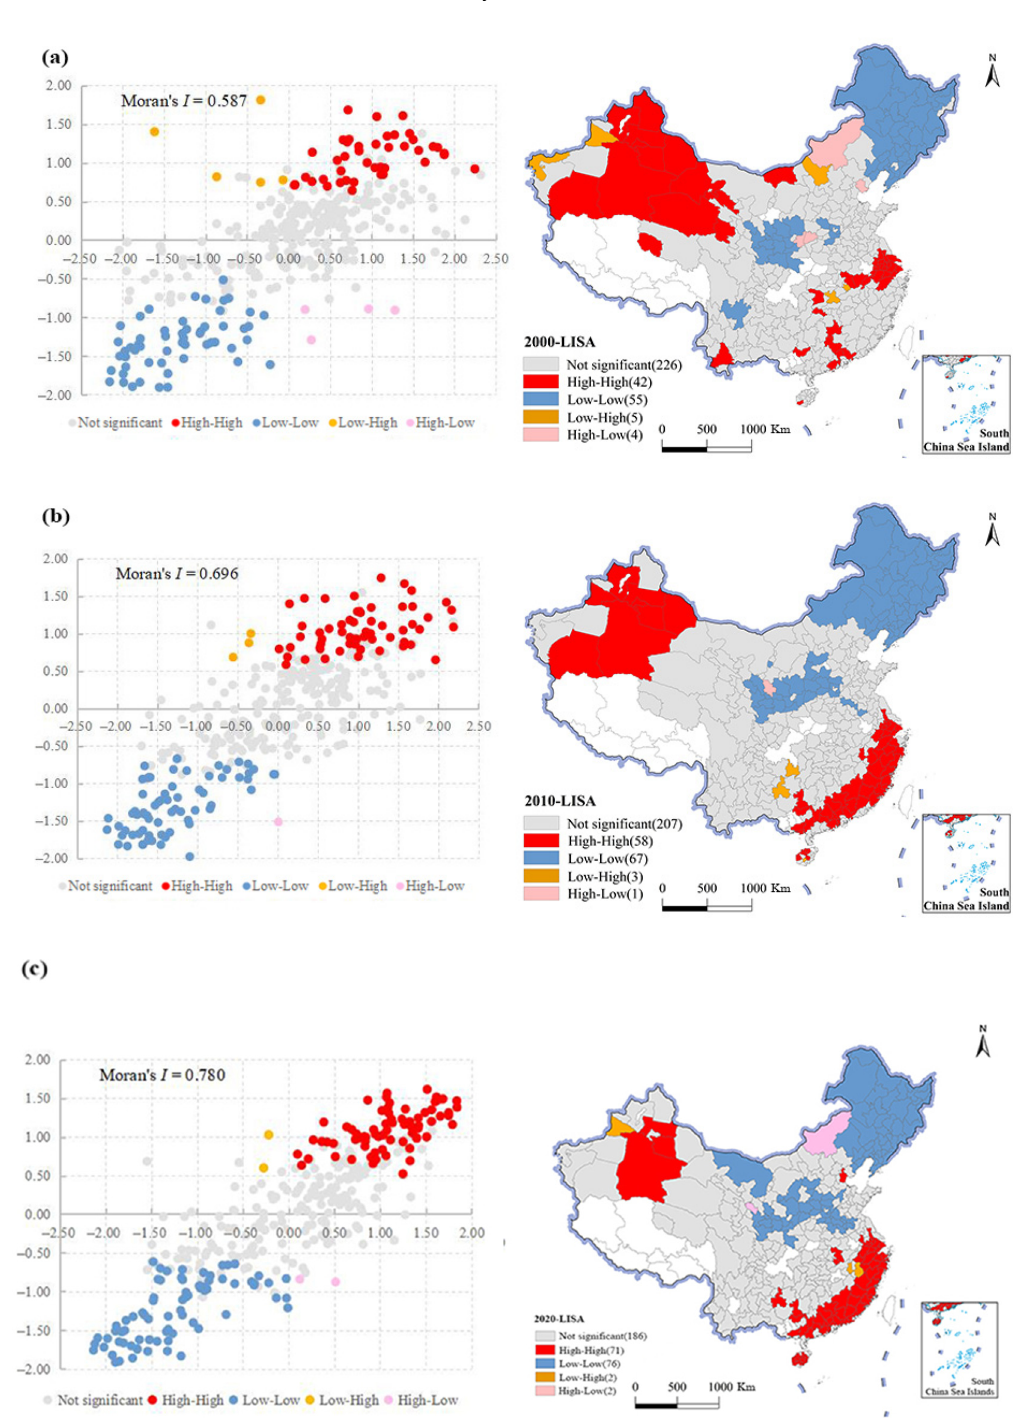
Figure 5. Moran scatter plot of NGPCL in China. ( a ) The Moran scatter plot in 2000; ( b ) the Moran scatter plot in 2010; ( c ) the Moran scatter plot in 2020.